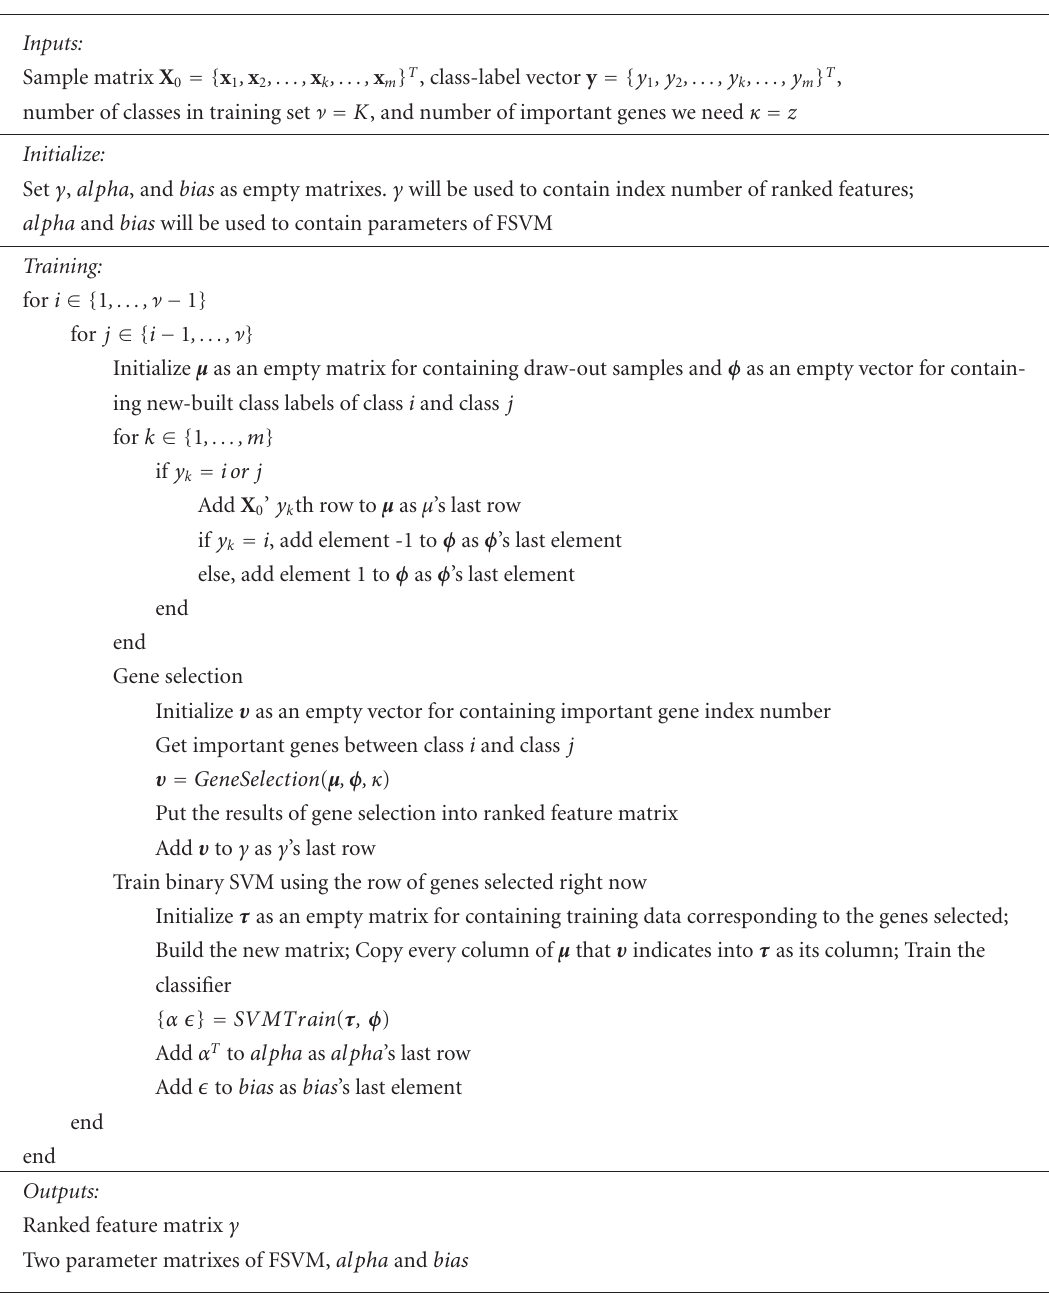
Algorithm 1. The FSVM with gene selection training